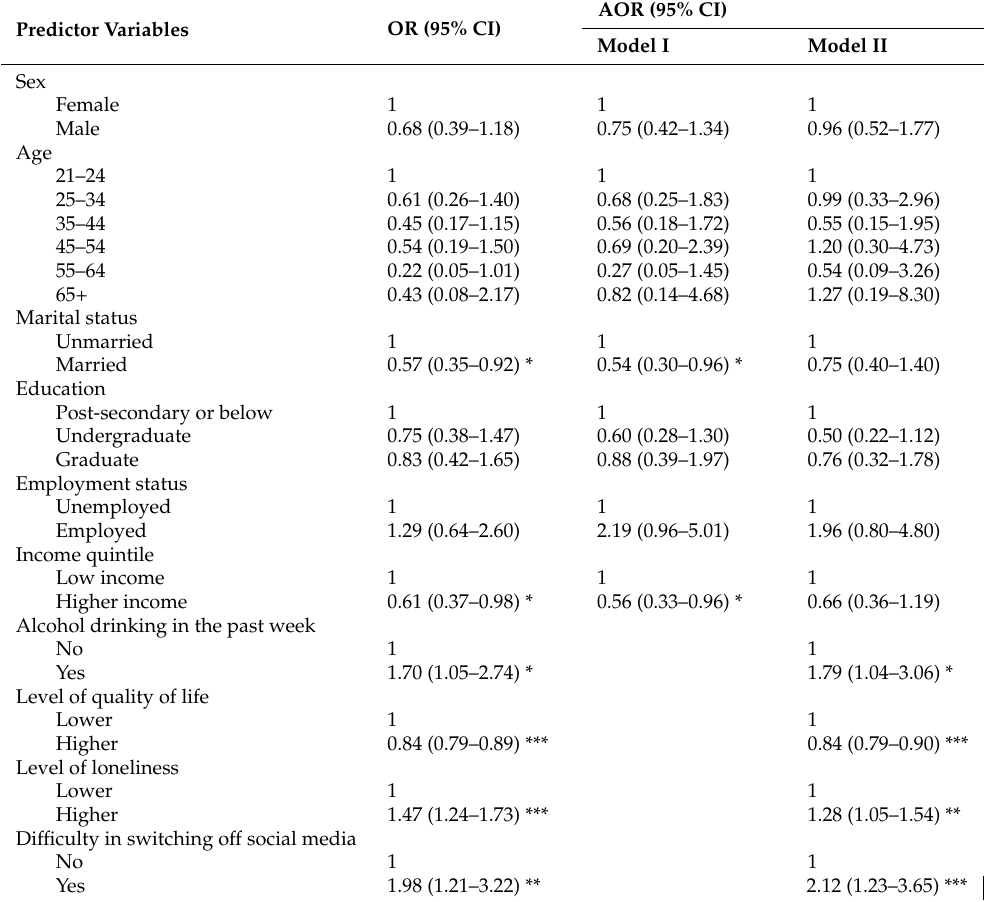
Table 2. Factors associated with anxiety symptom levels (GAD-7) before the COVID-19 pandemic in ordered logistic regression analysis (n =